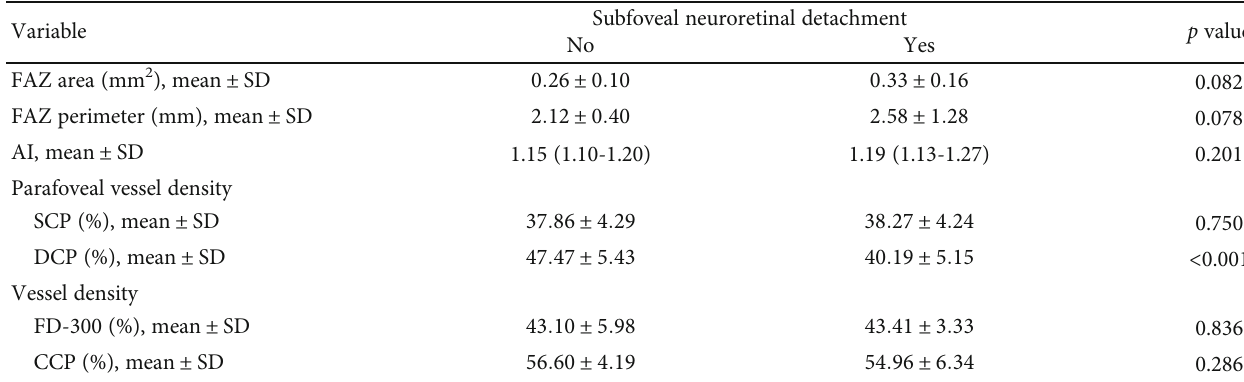
Table 2: Comparisons of parameters at the foveal avascular zone and the foveal microcirculation between the eyes with and without subfoveal neuroretinal